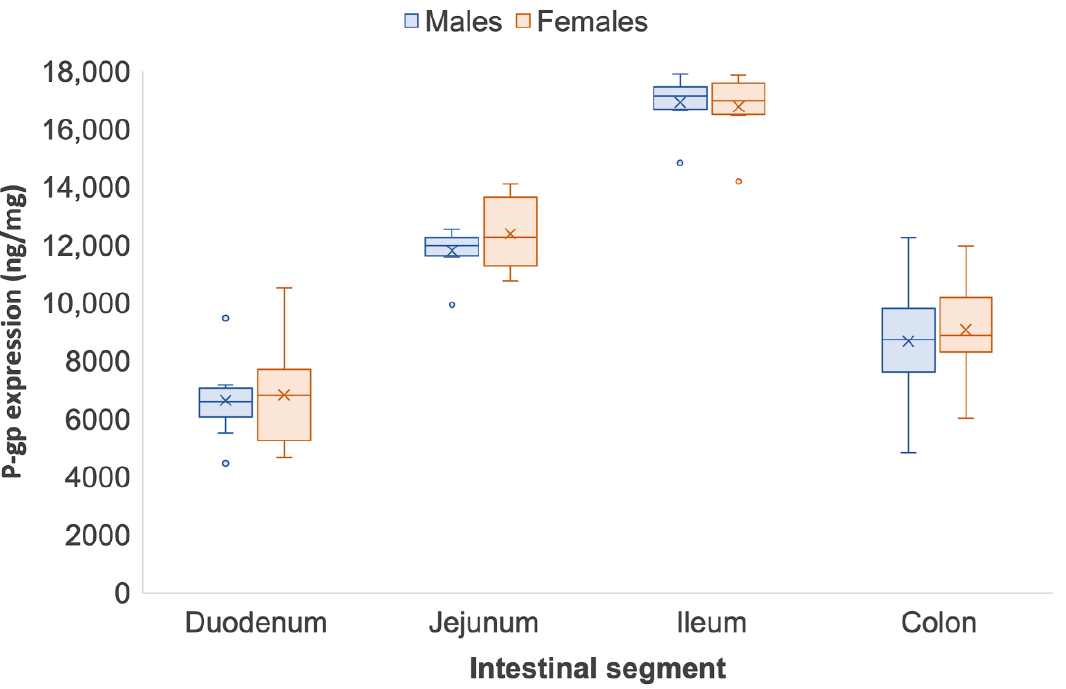
Figure 4. Regional and sex differences in P-gp expression in male and female Sprague Dawley rats quantified by LC-MS/MS. Data are represented as mean ± S.D., n = 8. Regional differences are statistically significant from the small intestinal segments to the colon ( p < 0.05).